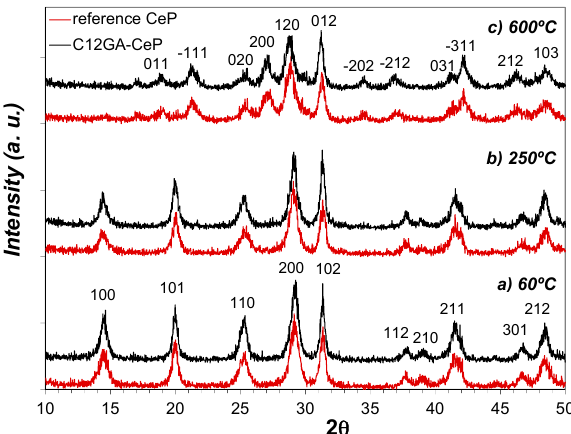
Figure 8. XRD patterns with the evolution of crystalline phase in non-templated reference CePO 4 (bottom, red-colored) and C12GA-templated CePO 4 (up; dark-colored): ( a ) as-prepared 60 °C-dried samples; ( b ) 250 °C-annealed samples (air conditions); ( c ) 600 °C-annealed samples (air conditions).